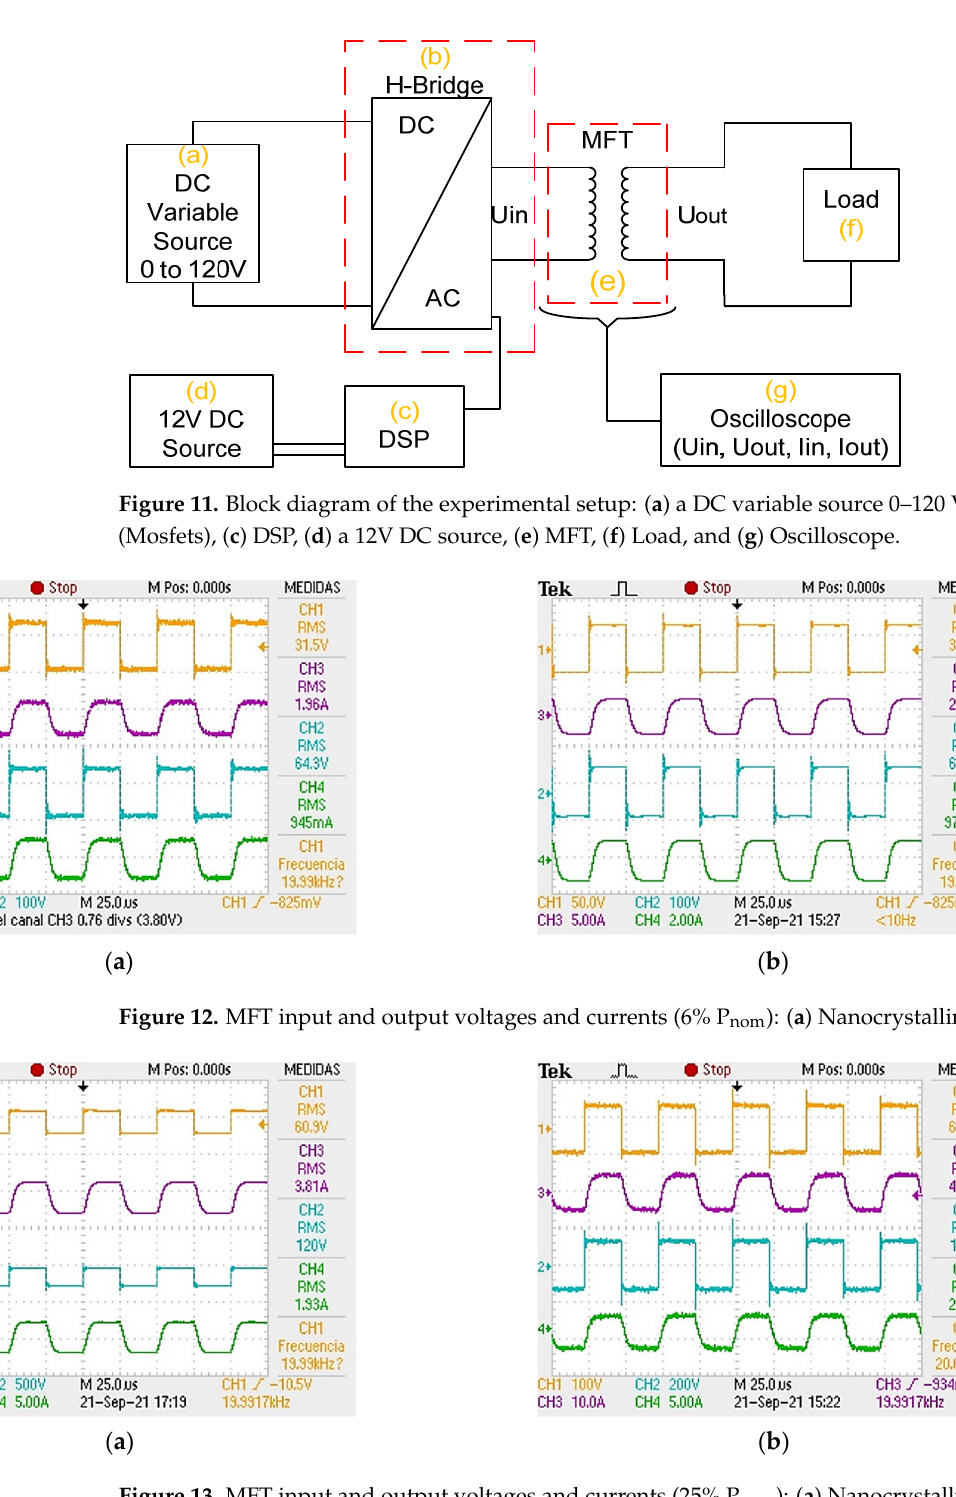
a DC variable source 0–120 V, ( b ) H Bridge (Mosfets), ( c ) DSP, ( d ) a 12V DC source, ( e ) MFT, ( f )